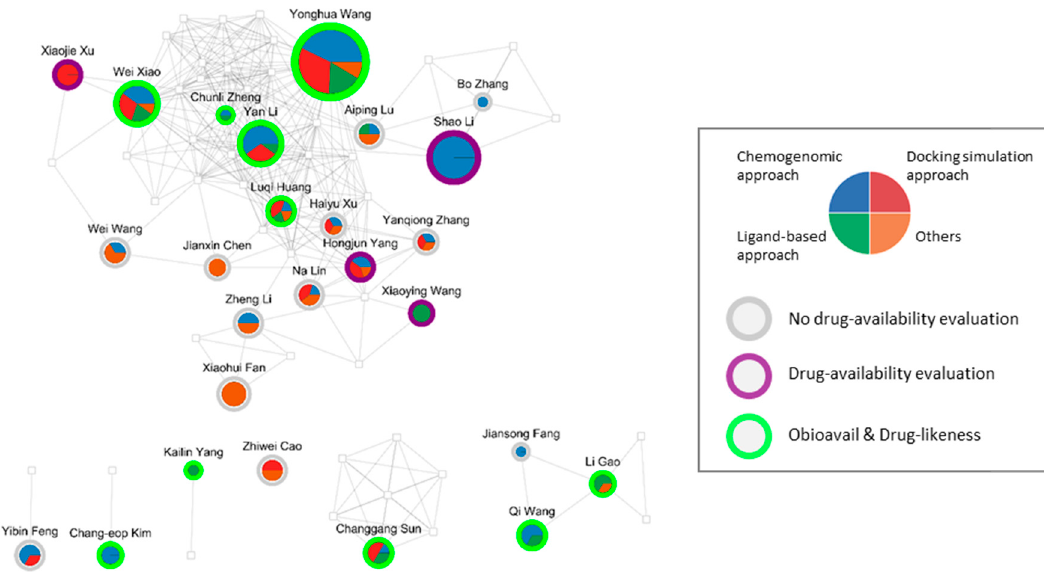
Figure 8. The co-author network of THM-NP studies. Circles represent corresponding authors, and squares represent non-corresponding authors. The size of the circles and squares reflect the number of occurrences in the THM-NP studies. Nodes that appeared fewer than three times were removed. The box to the right of the network represents the index for the pie chart and the outline of the circle. We also constructed and visualized the affiliation network (Supplementary Figure S1).